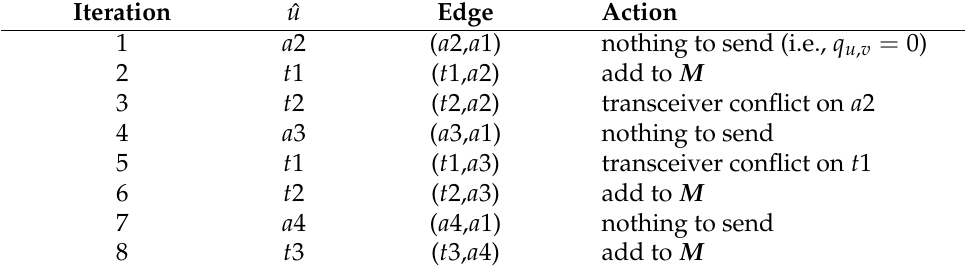
Table 6. Steps of the matching heuristic applied to the routing graph in Figure 16.